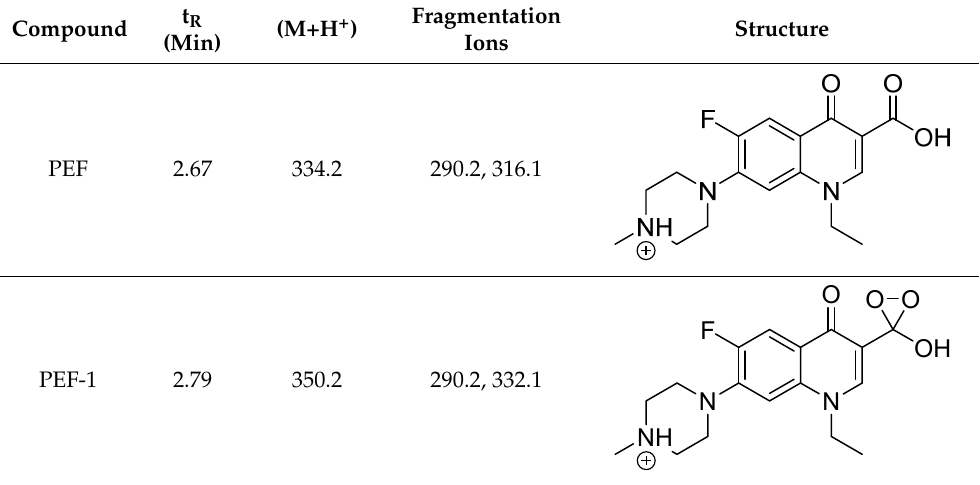
Table 5. Proposed structures of the degradation products of PEF.